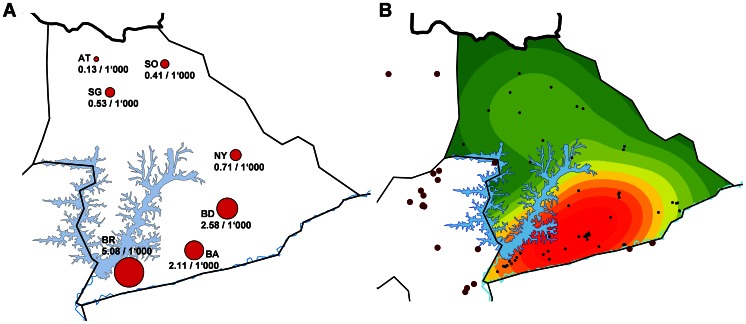
Geographic distribution of BU in the Mapé Basin.Based on the HA of origin of the 62 BU cases who originated within the Bankim HD and the population data collected in the survey, we computed the per HA cumulative incidence rate of BU in the Bankim HD (A). For detailed analysis, the places of residence of 58 (black points) of the 62 cases from the Bankim HD were mapped using a GPS device (B). For the remaining 4 RT-PCR confirmed cases which occurred inside the Bankim HD (3 from the Bandam HA, 1 from the Somié HA) we could not identify their home. Using a Kernel function the density of BU in the Bankim HD was computed based on the mapped cases (red: highest BU density). Panel B further shows the places of residence of 21 of the 26 RT-PCR confirmed cases of BU who originated from outside of the Bankim HD (brown points). For three of the remaining cases (1 from the Malantouen HD, and 2 of unknown origin) we could not identify their exact origin and two additional cases (1 each from the Nwa HD and Mayo Darle HD) are not shown because they originated from outside of the region shown on the map.